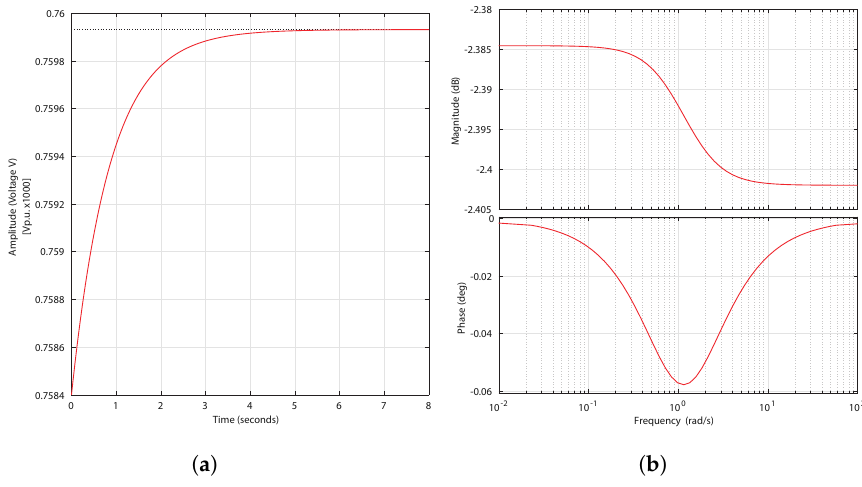
Figure 5. Reactive power to voltage transfer function G VQ ( s ) characteristics. ( a ) G VQ ( s ) step response. ( b ) G VQ ( s ) bode diagram.